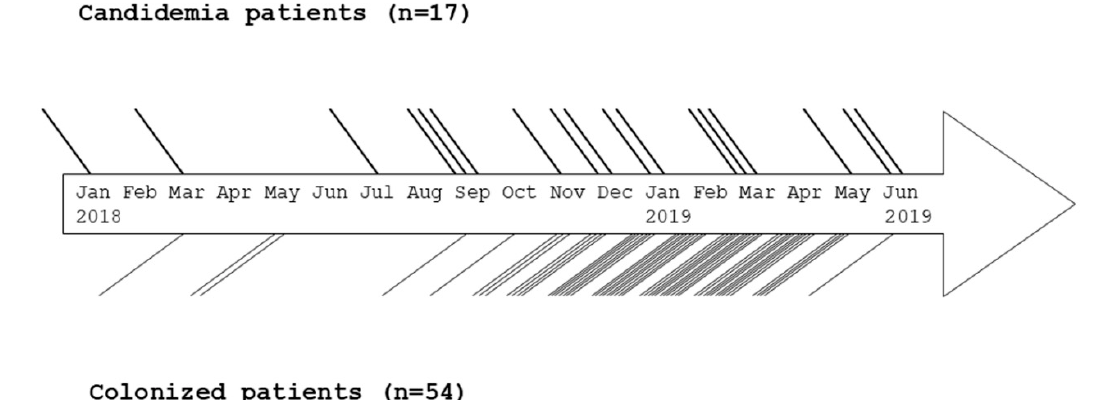
Figure 1. Timeline for the detection of patients with candidemia and colonization due to C. auris in Farwaniya Hospital during the course of outbreak from January 2018 to June 2019. Number of thick and thin lines indicate number of candidemia and colonized patients, respectively, detected in each month and the spacing between the lines within a month or between months is not relevant. Some candidemia patients also yielded C. auris from other anatomic sites, but they are not included among colonized cases. Multiple C. auris isolates were obtained over time from many anatomic sites from most of the colonized patients. None of the colonized patient yielded C. auris from